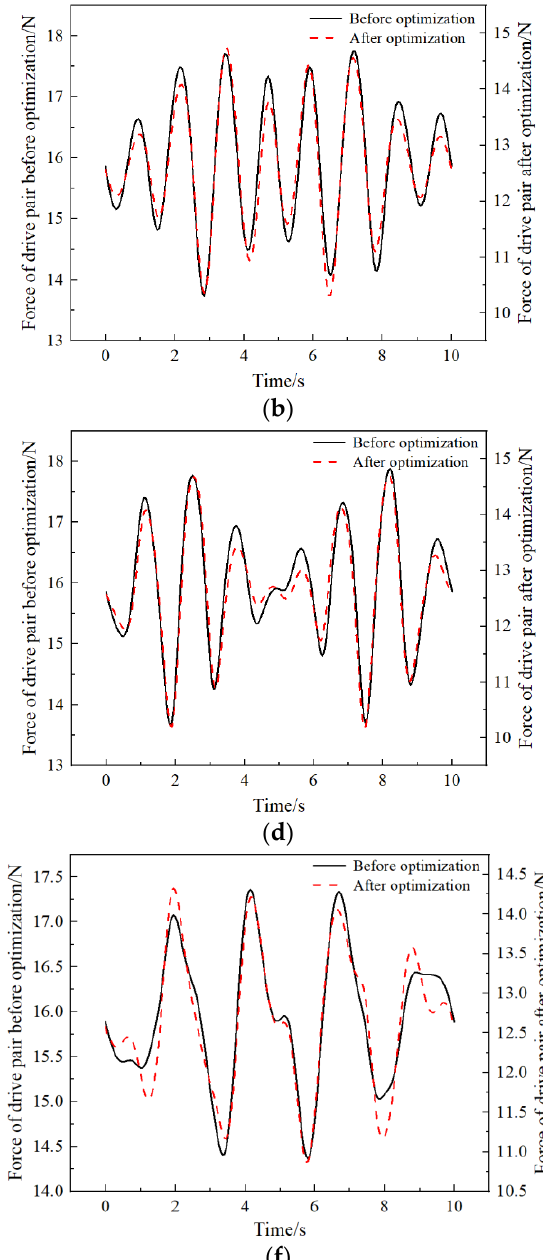
Table 9. The peak force on the drive pair of the drive branch chain.